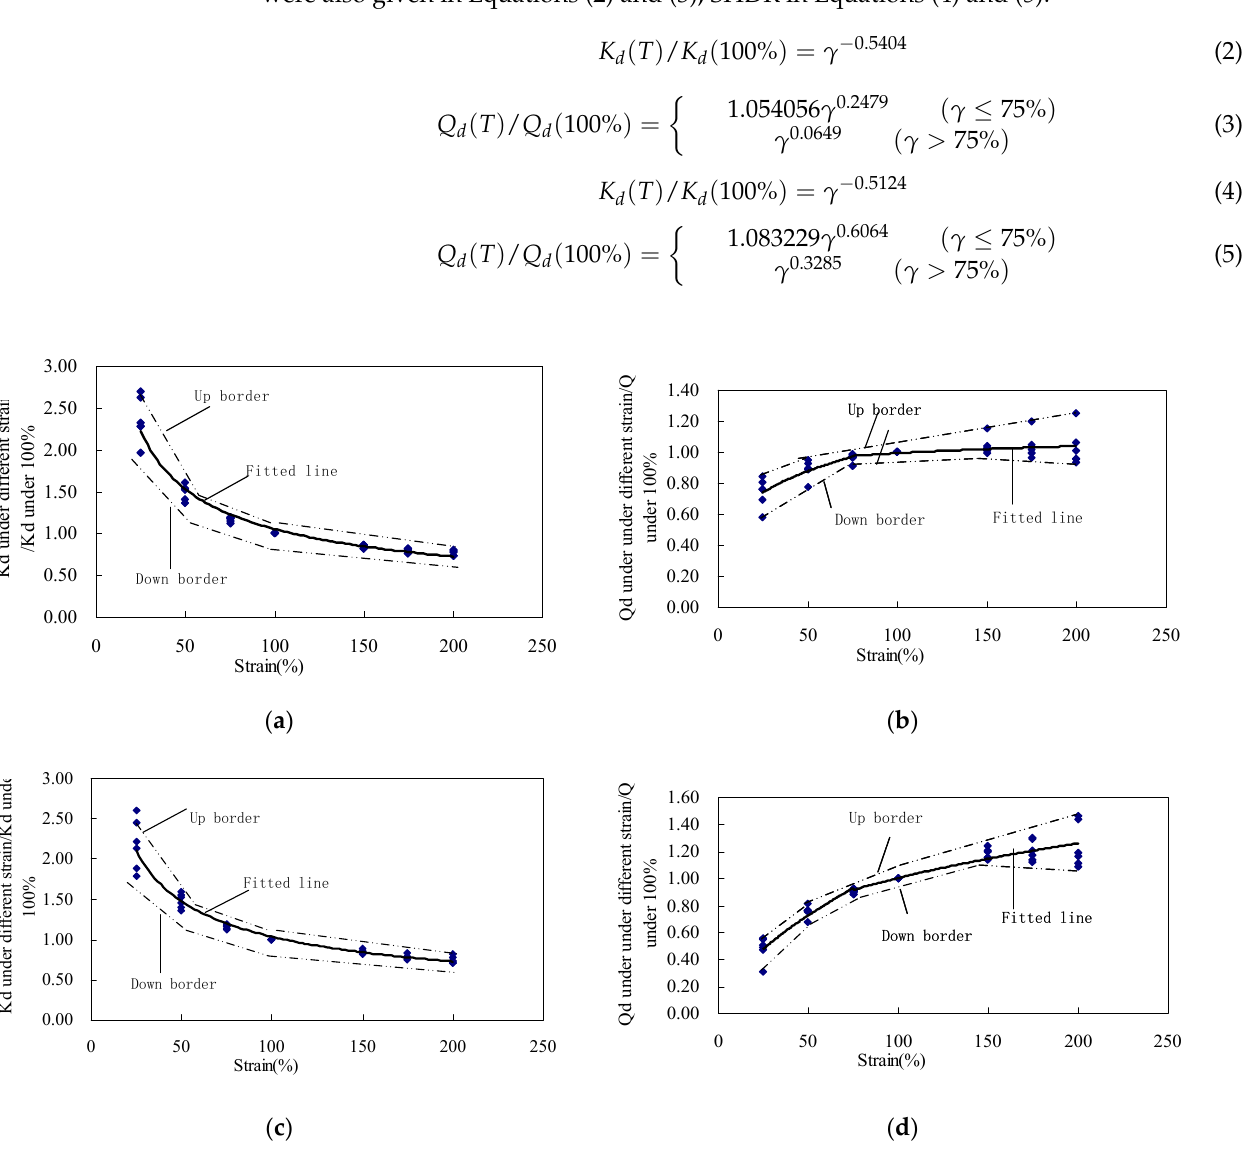
Figure 9. The test data and fitted curve of LRB and SHDR: ( a ) K d for LRB; ( b ) Q d for LRB; ( c ) K d for SHDR; ( d ) Q d for SHDR.